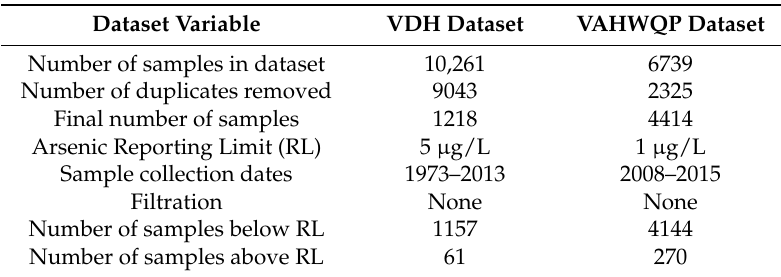
Table 1. Summary of datasets used for this study. VDH = Virginia Department of Health; VAHWQP = Virginia Household Water Quality